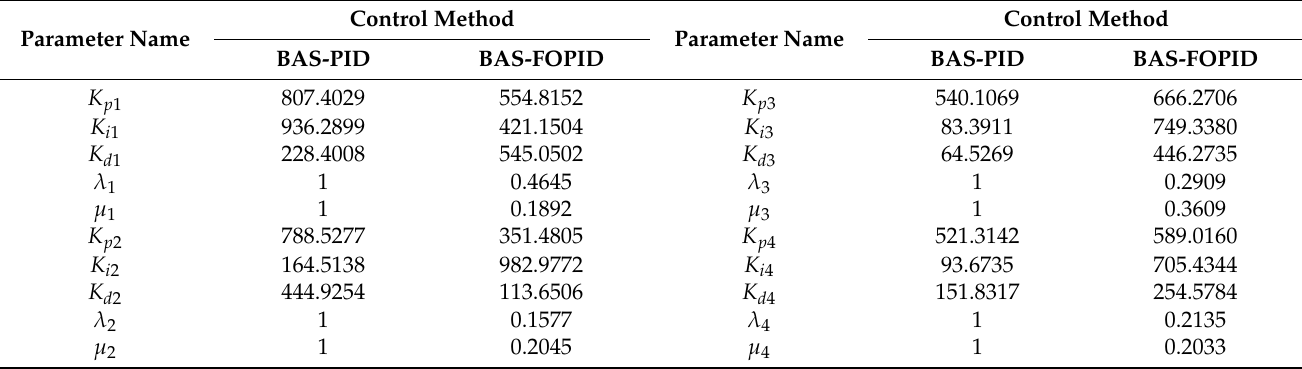
Figure 13. Optimization flow chart of Beetle Antennae Search Algorithm. The controller parameters were obtained by using the Beetle Antennae Search Algo- rithm to find the optimal controller parameters several times, as shown in Table 2 below. Table 2. Controller parameters adjustment